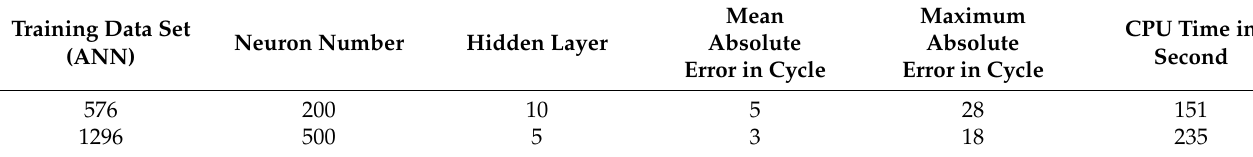
Table 10. Comparison of ANN regression result for